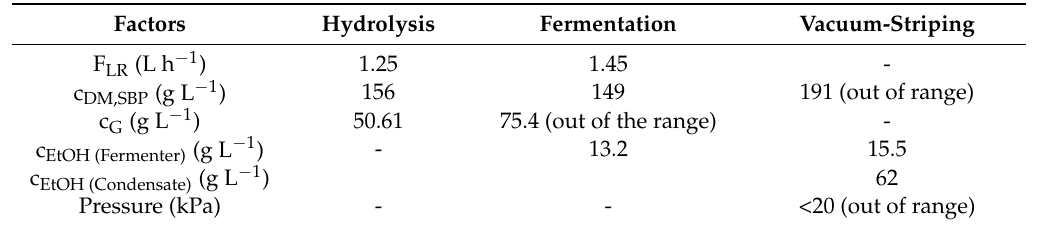
Table 3. Optimal and critical values for parameters (factors) tested in gas striping vacuum assisted recovery system for ethanol removal from the column